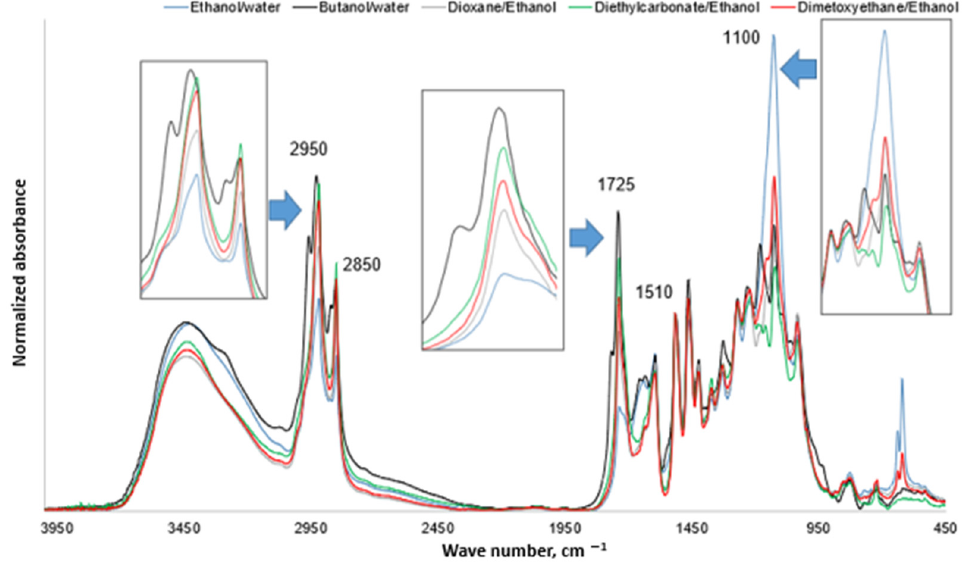
Figure 6. FTIR spectra of obtained lignin-enriched fractions normalized at 1510 cm − 1 .